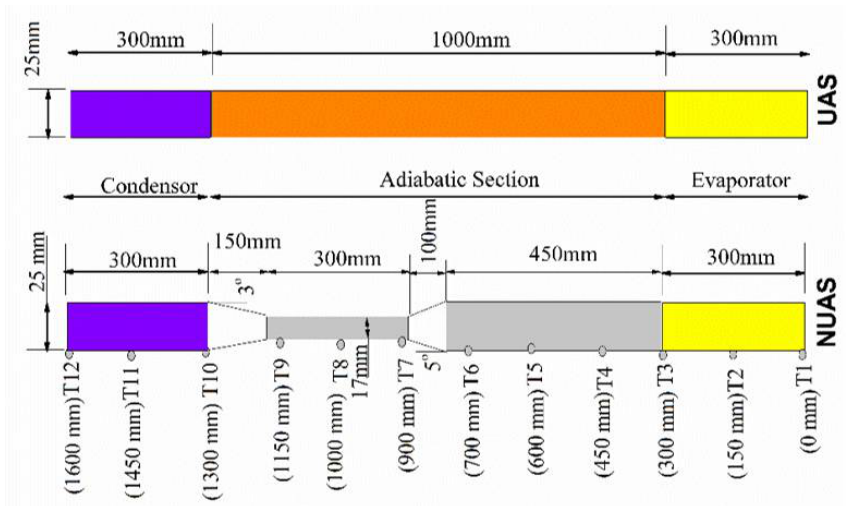
Figure 2. The dimension of UAS, NUAS and thermocouple placement.